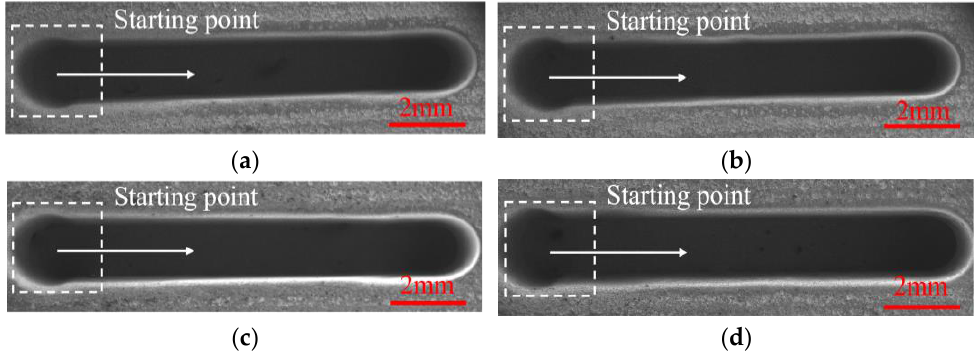
Figure 12. The SEM images of DNGs generated under different spindle speeds. ( a ) Spindle speed = 2500 rpm; ( b ) spindle speed =3000 rpm; ( c ) spindle speed = 3500 rpm; ( d ) spindle speed = 4000 rpm.